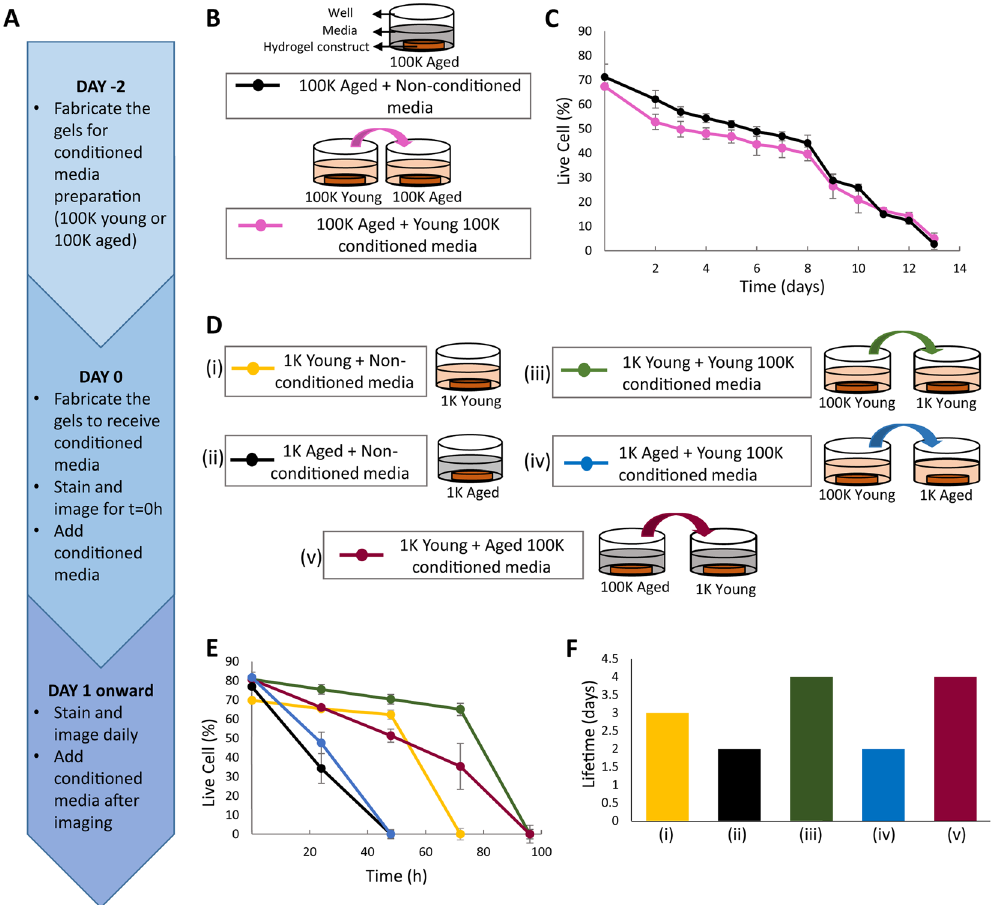
Figure 4. Determining the effect of secreted factors on failure of synthetic tissues made from young or pre-aged cells. ( A ) The timeline for conditioned media experiments. ( B ) The schematic of media transfer and ( C ) the live cell percentage change over time of synthetic tissues with 100 K pre-aged cells receiving 100 K young synthetic tissue conditioned or non-conditioned media. ( D ) The schematic of media transfer experiment of synthetic tissues made from young or pre-aged cells at 1 K density, receiving 100 K young or 100 K pre-aged synthetic tissue conditioned media. Synthetic tissues maintained in non-conditioned media are used as controls. ( E ) The live cell percentages of 1 K synthetic tissues receiving non-conditioned (control) or conditioned media. ( F ) The lifetime of synthetic tissues made from young or pre-aged cells at 1 K density receiving 100 K young or 100 K pre-aged synthetic tissue conditioned or non-conditioned